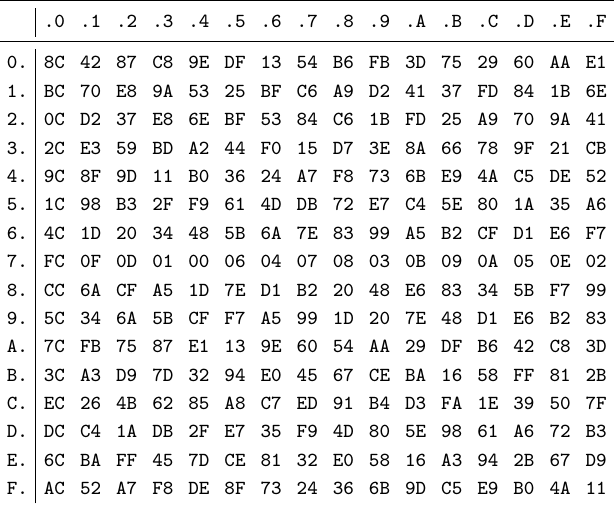
Table 3: The look-up table of 𝐹 𝜋 , a function CCZ-equivalent to 𝜋